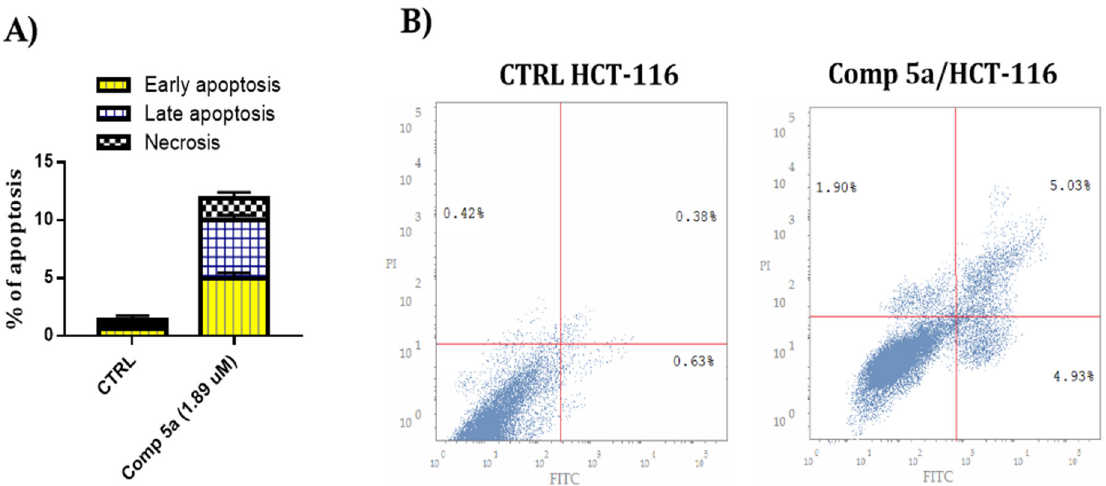
Figure 3. ( A ) Graphical representation of apoptosis effect of compound 5a on HCT-116 cell line. ( B ) Apoptosis effect of compound 5a on HCT-116 cell line.